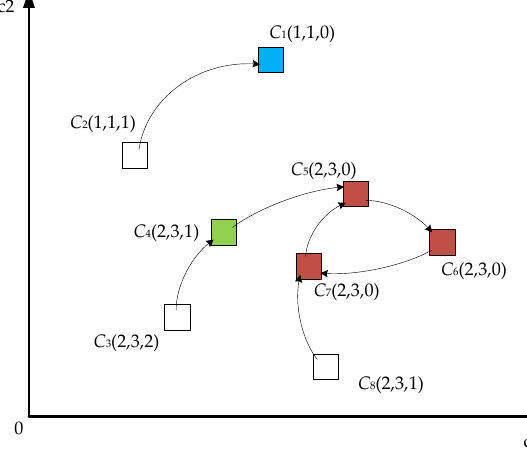
Figure 5. Cell mapping example of a two-dimension system.